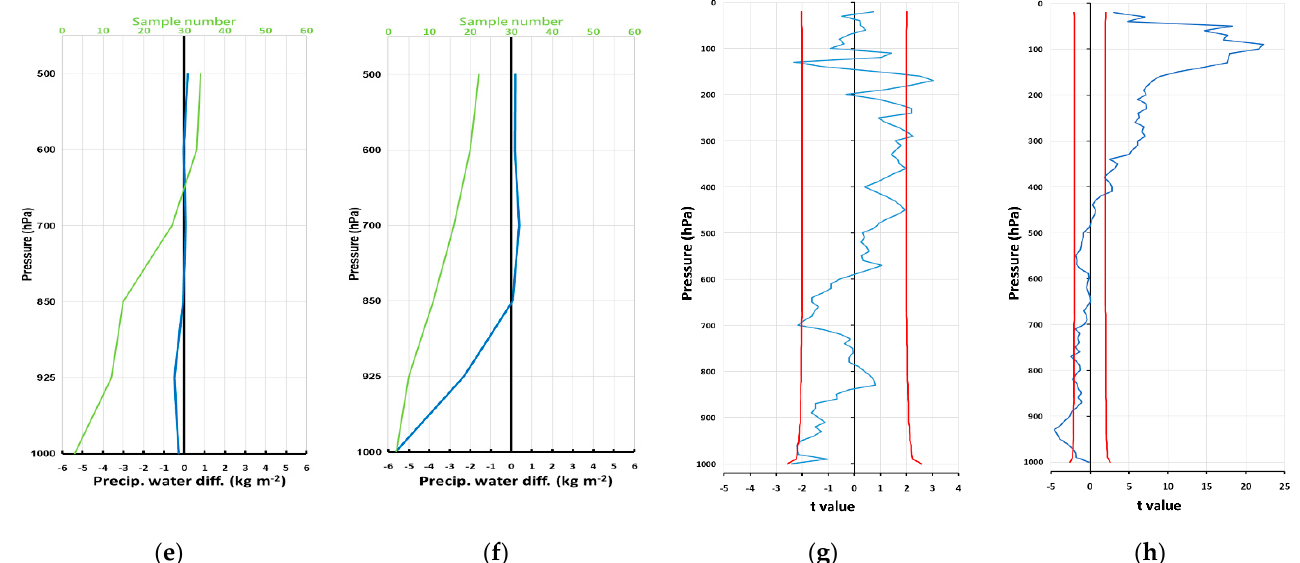
Figure 5. The average ( a , b ) temperature difference, ( c , d ) specific humidity difference, and ( e , f ) precipitable water differ- ence of the sampled COSMIC-2/FORMOSAT-7 RO profiles minus nearby radiosonde profiles for the ( a , c , e ) sunny and ( b , d , f ) cloudy/rainy groups. The blue and green curves in ( a – f ) denote the average differences and sample numbers, respectively. The red curves in ( a – d ) denote the standard deviations of the temperature and specific humidity differences. The profiles of the paired t-tests for ( g ) temperature and ( h ) specific humidity are also shown, where the blue and red curves denote the t values and critical values, respectively.